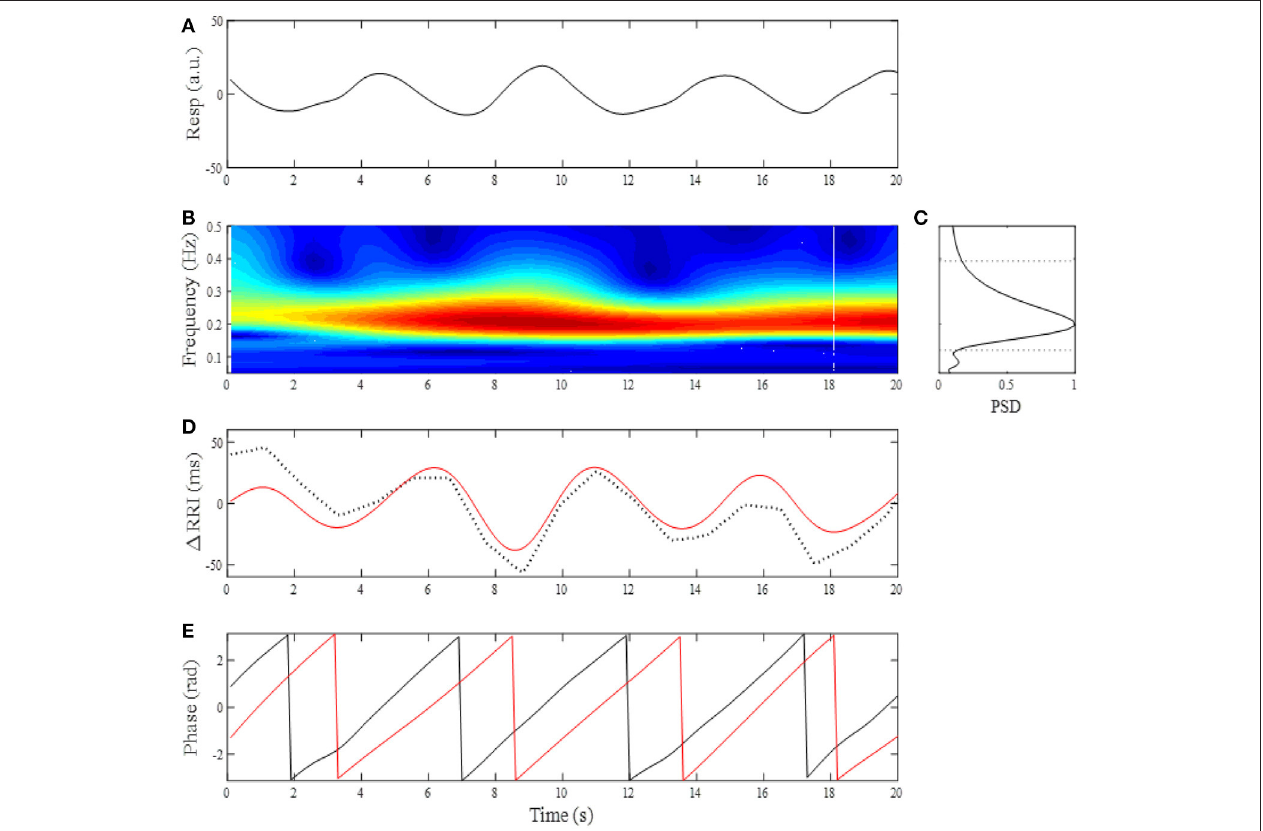
FIGURE 1 | (A) Changes in breathing trace (Resp, upward deflections denote expiration) for a 20-s time window. (B) Time-frequency representation by CWT for breathing. (C) Mean power spectral density (PSD) profile in the normalized form. The corner frequencies of passband filter for determining RSA were estimated by the frequencies where PSD reduced to 20% of its maximum power (horizontal dotted lines). (D) Change in RRI (dotted curve) and extracted RSA (red curve). (E) Instantaneous phases for breathing (black line) and RSA (red